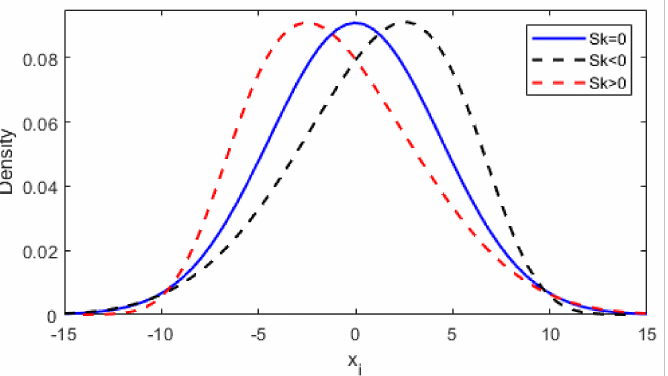
Figure 1. Distortion of the probability distribution for different values of the skewness parameter.